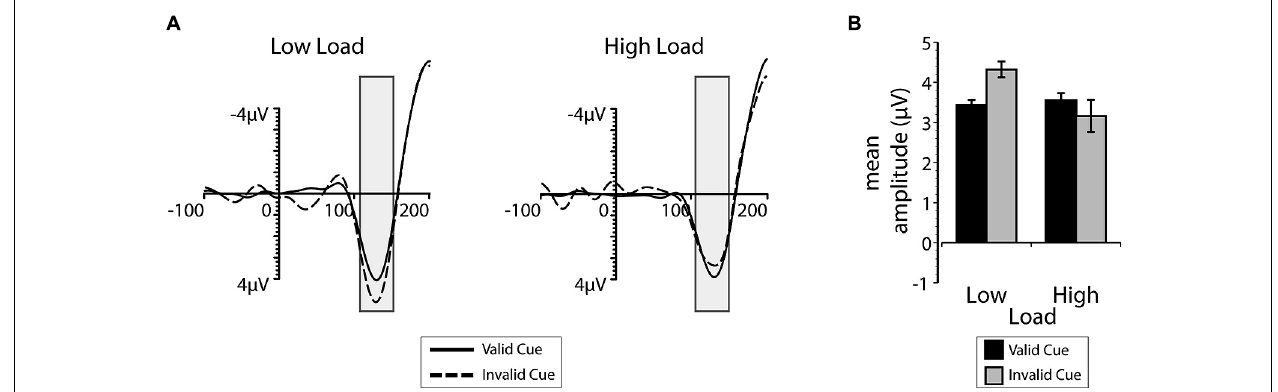
dashed line. (B) The mean P1 amplitude contralateral to the irrelevant flanker, plotted as a function of cue validity (valid in black and invalid in gray) and load. Error bars plotted within this figure represent the standard error of the mean appropriate for within-subjects comparisons (Loftus and Masson,